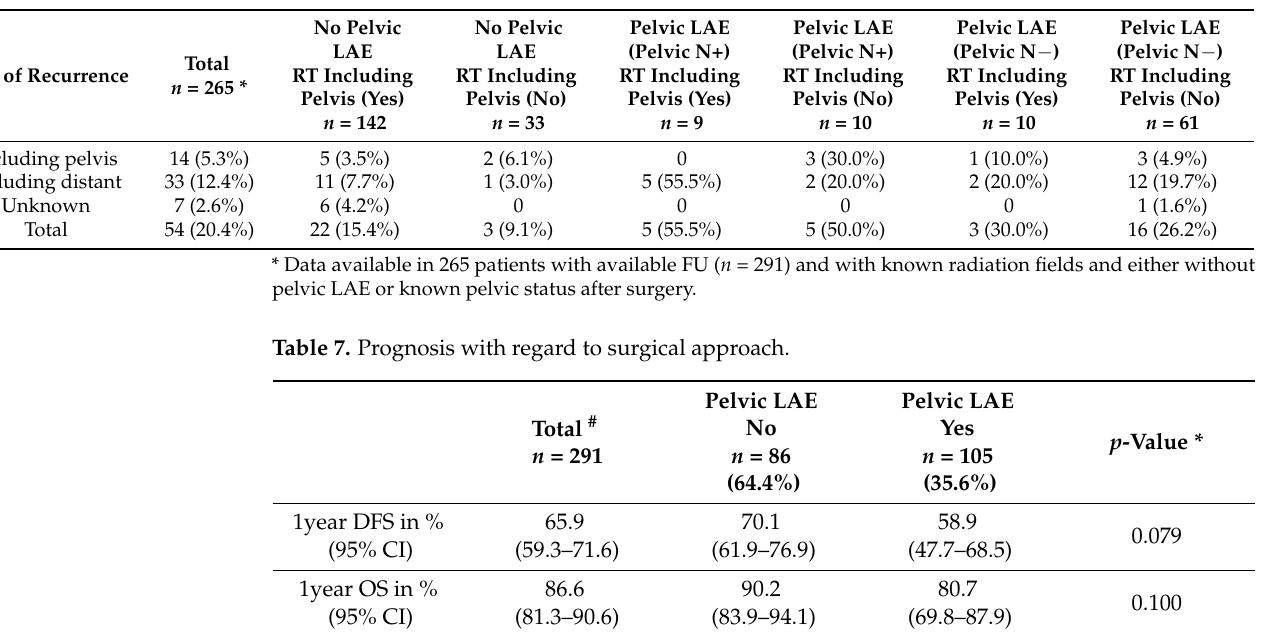
* Follow-up data available in 291 patients. Table 6. Pelvic recurrences with regard to radiation field.